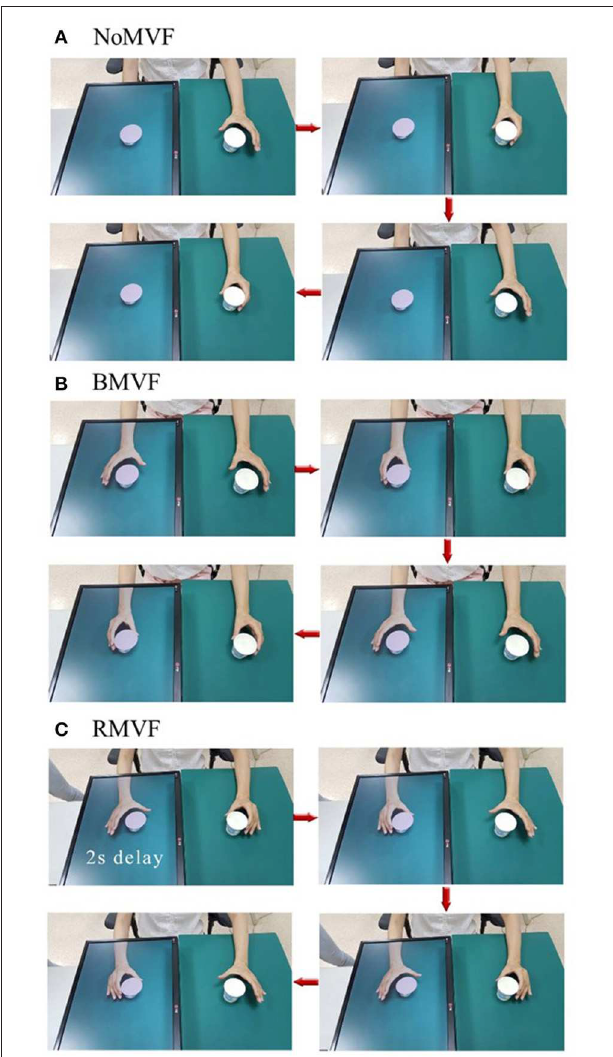
FIGURE 2 | Operation process of three test conditions that were used to test their impact on sensorimotor cortical activity. (A) The mirror area showed only a paper cup with a still image of the mirror area without the hand (NoMVF condition). (B) The mirror area showed synchronous, simultaneous mirrored images of the movements of the left hand with bilateral task-based mirror visual feedback (MVF; BMVF condition). (C) The mirrored images of the movements of the left hand were shown in a 2-s delay of the reciprocal action task-based MVF (RMVF